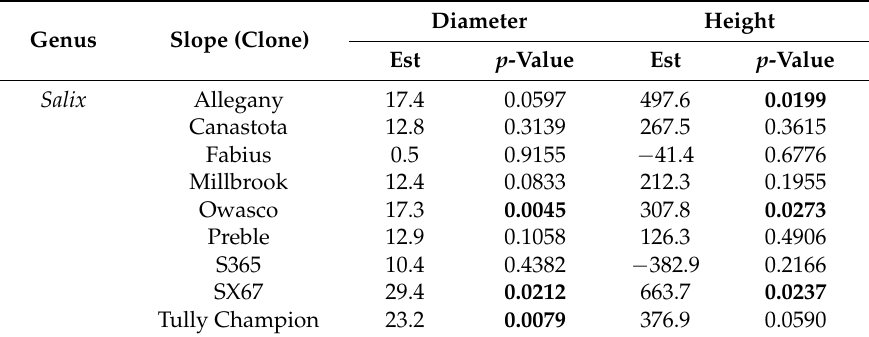
Table 8. Slope parameter estimates and associated p -values for the relationship between root–shoot ratio (RSR) with diameter and height in a study assessing the relationships among root–shoot allocations, early growth, and health of hybrid poplar and willow clones when grown for 65 days in soils from five landfills in eastern Wisconsin, USA. Diameter Height Genus Slope (Clone) Est p -Value Est p -Value Salix